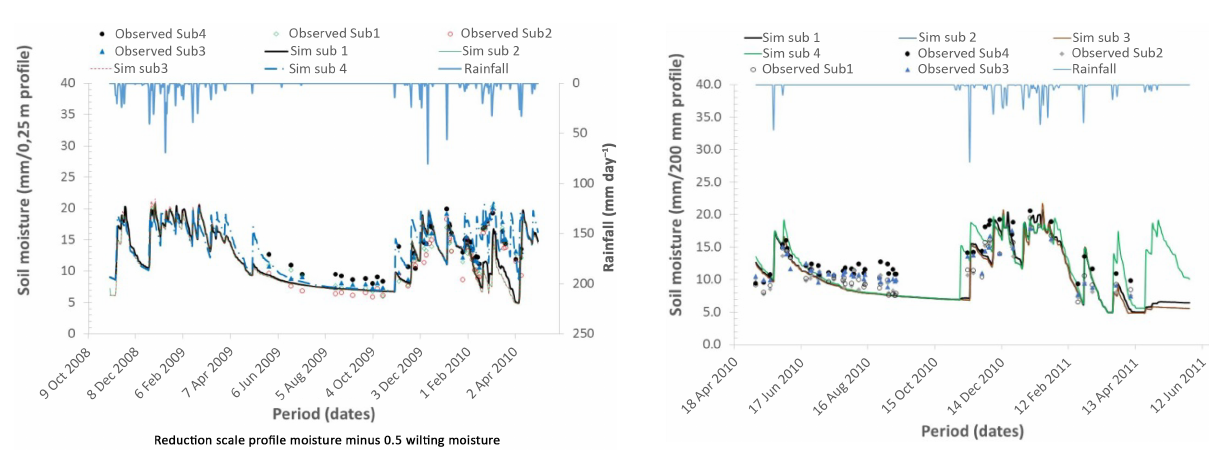
Figure 4. Model performance with reduction scale based on pre- vailing soil moisture.